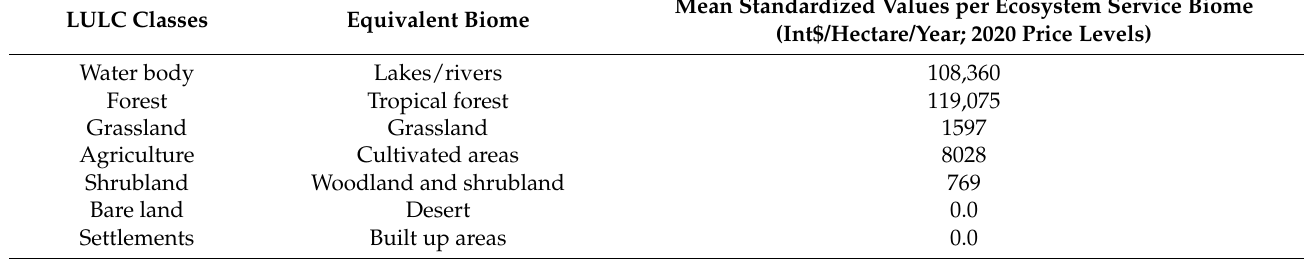
Table 3. Land use and land cover (LULC) classes, the corresponding biomes and mean standardized values per ecosystem service biome based on the updated values [34].